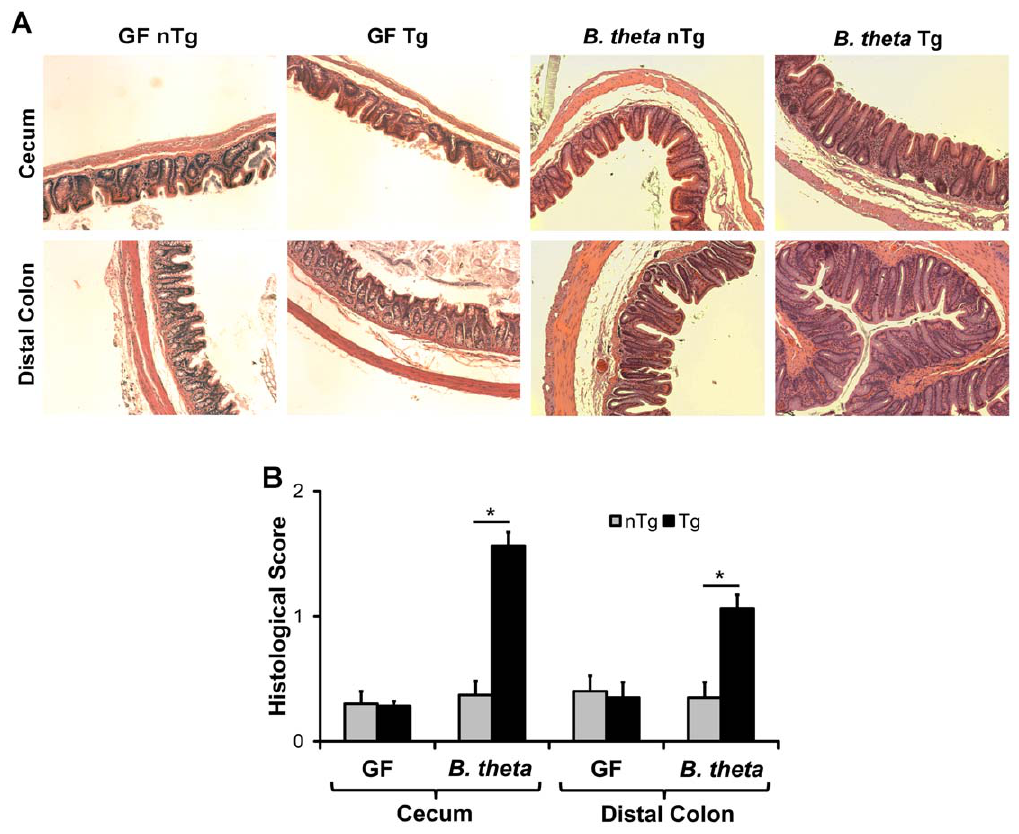
Figure 1. Colonic Inflammation in Germ-Free and B.theta Monoassociated Rats. (A) Representative photomicrographs of H&E stained cecum and distal colon pieces from germ-free (GF) and 6-week B. theta -monoassociated non-transgenic (nTg) and HLA-B27 transgenic (Tg) rats taken using a 10 6 objective. (B) Blinded histological inflammation scores of cecum and distal colon tissue from GF and B. theta -monoassociated rats (mean + SEM, *p , 0.05, n=4–5 rats/group).